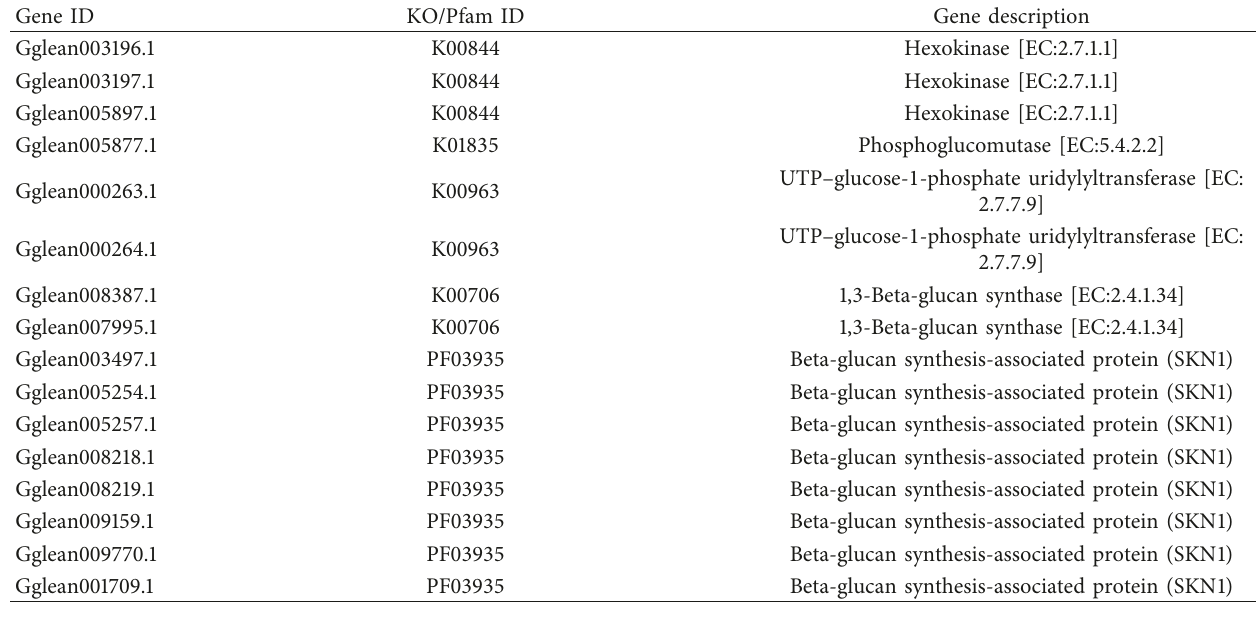
Table 5: Genes involved in polysaccharide biosynthesis.